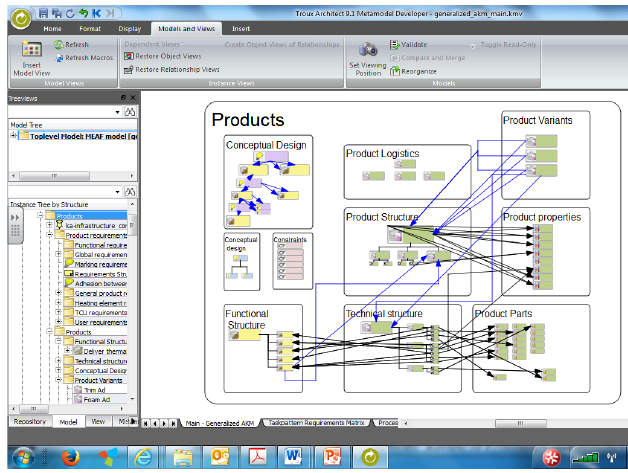
Fig. 5. Product perspective taken from an enterprise model (i.e., screenshot from a modelling